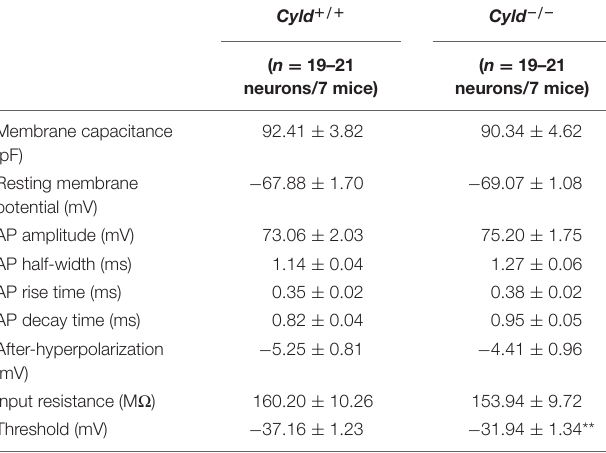
TABLE 1 | Intrinsic properties of the BLA principal neurons in Cyld + / + and Cyld − / − mice.